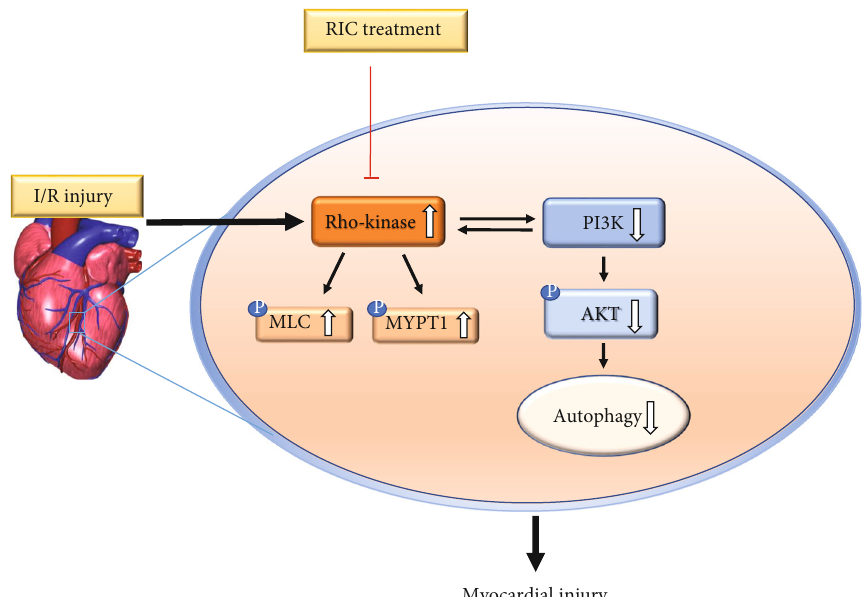
Figure 7: Schematic diagram summarizing the possible mechanisms of Rho-kinase and the PI3K/AKT pathway in RIC.RIC is a novel therapy that protects against myocardial I/R injury by inhibiting Rho-kinase activity and activating the PI3K/AKT pathway to enhance autophagy. Black solid arrows indicate positive e ff ects, red lines with vertical bars indicate negative e ff ects, and black hollow arrows indicate up or down